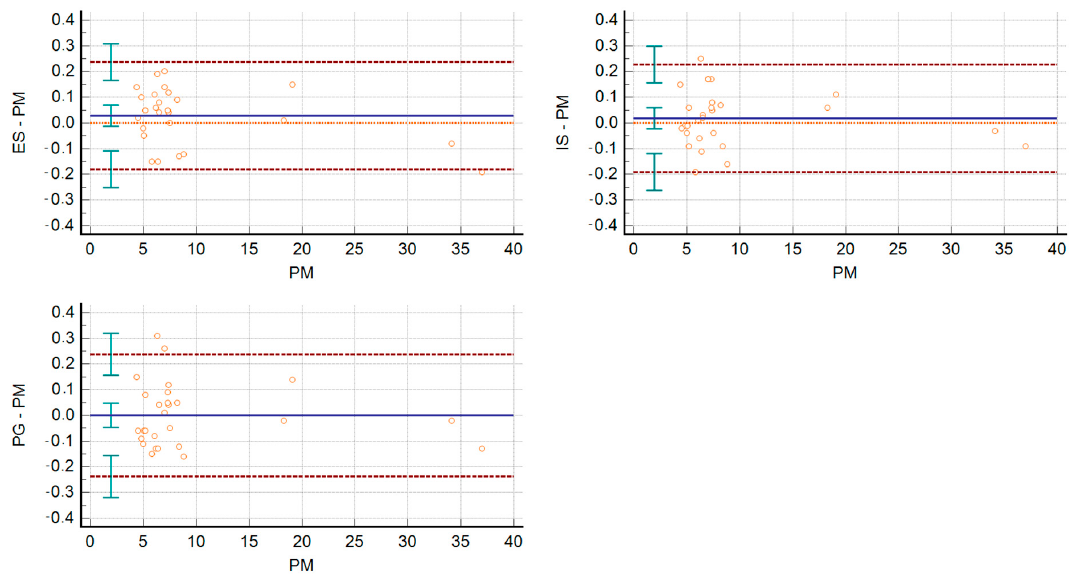
Figure 6. Bland–Altman graphs to visualize the agreement of the measurements taken on the 3 digital models with those taken on the plaster model.